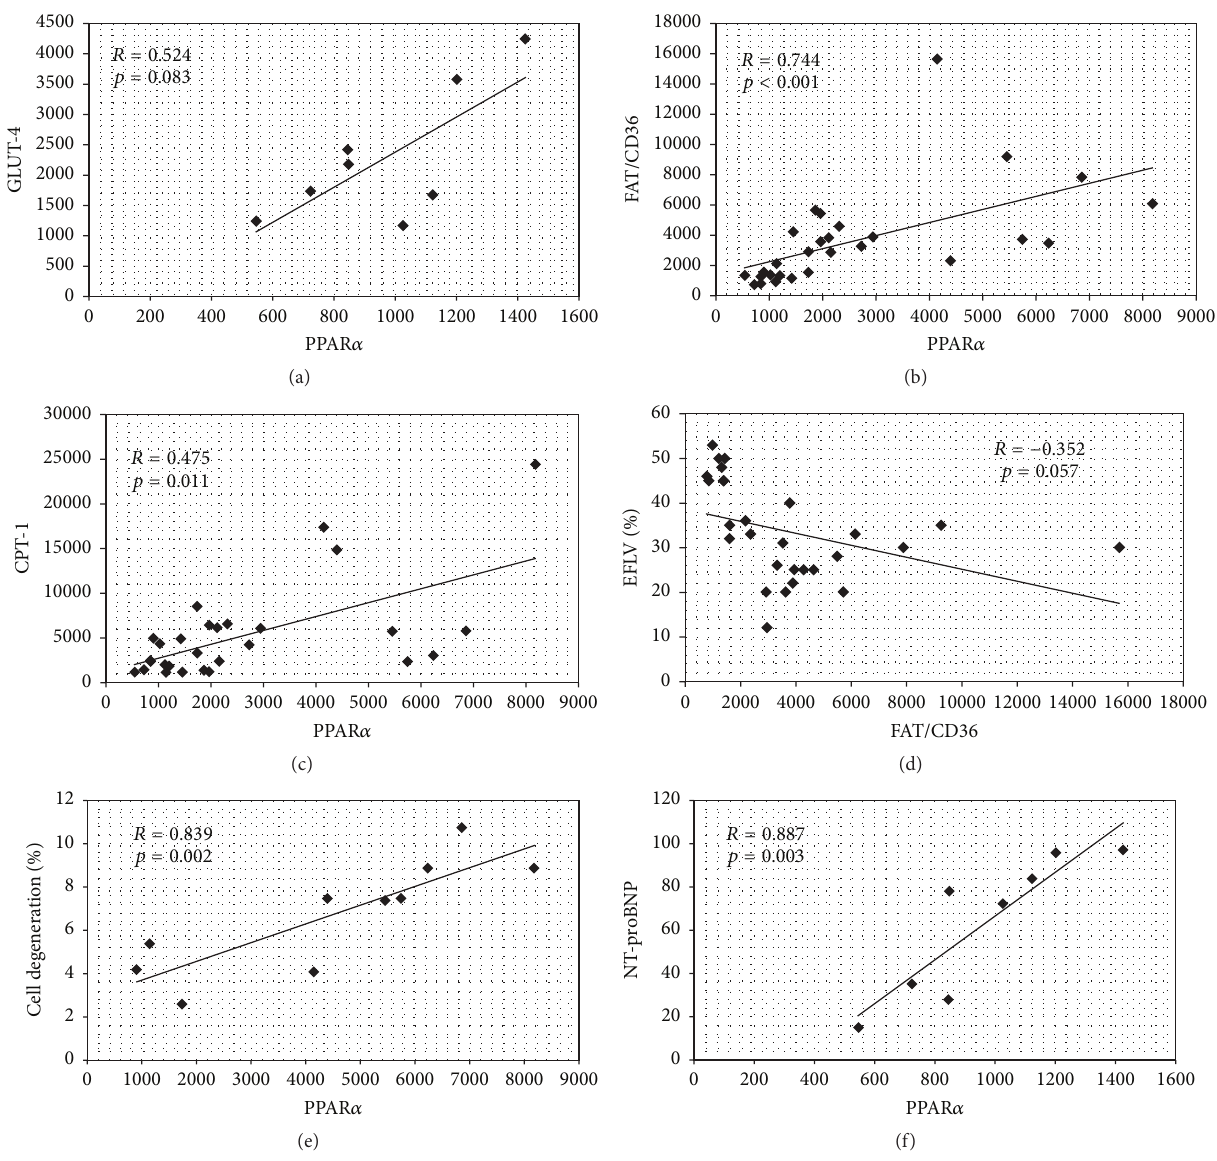
Figure 5: Association between PPAR 𝛼 and metabolic and structural anomalies. Results of analyses for patients Group (I): (a) PPAR 𝛼 and GLUT-4 mRNA for patients Group (I) and for all hearts with HF: (b) PPAR 𝛼 and FAT/CD36 mRNA; (c) PPAR 𝛼 and CPT; (d) FAT/CD36 mRNA and LVEF and for patients Group (II): (e) PPAR 𝛼 mRNA and cell degeneration and (f) PPAR 𝛼 mRNA and serum NT-proBNP level.